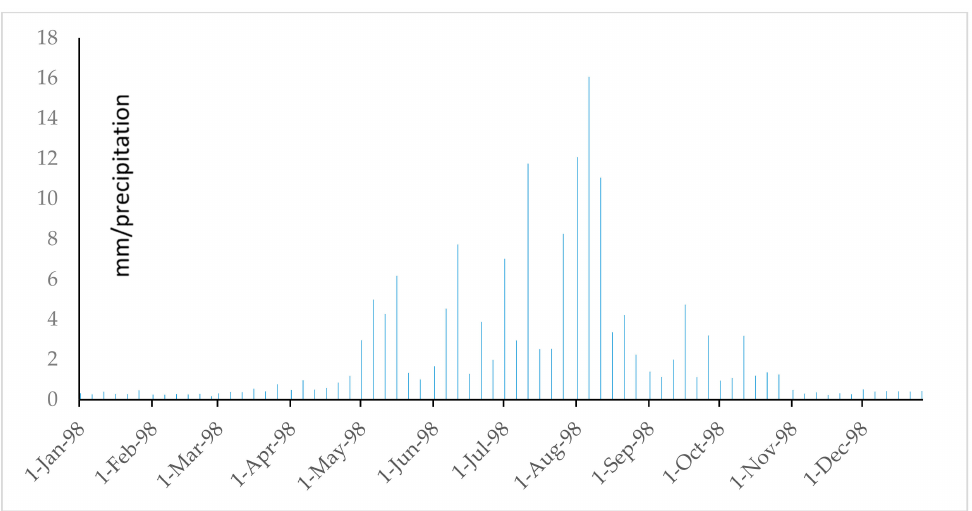
Figure A25. Precipitation of Denko County in 1997.